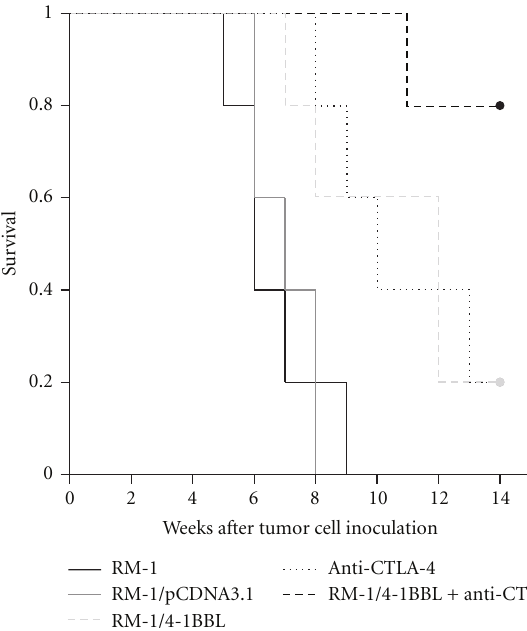
Figure 5: Kaplan-Meier survival curve of mice. According to the log-rank test, there were significant di ff erences among five groups ( P < 0 . 05). Compared with those of the other two groups, the survival rate of mice immunized with 4-1BBL-expressing cellular vaccines combined with CTLA-4 blockade was significant higher than those of mice immunized with either alone ( P < 0 .